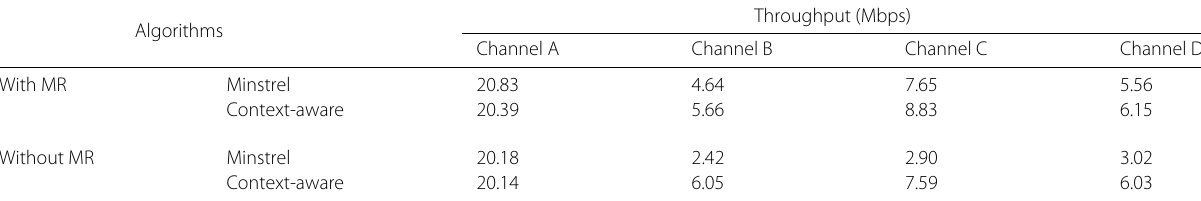
Table 5 Performance comparison in the emulated channels